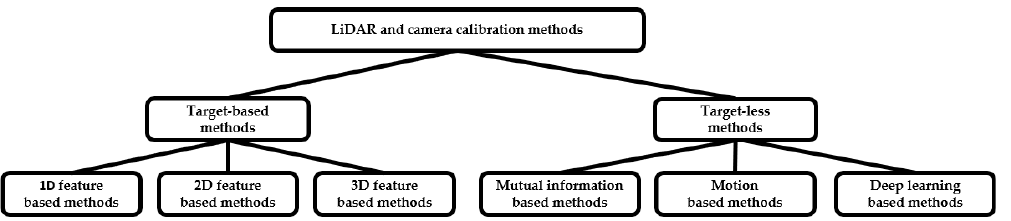
Figure 1. The representative methods of calibration between the LiDAR and visible light